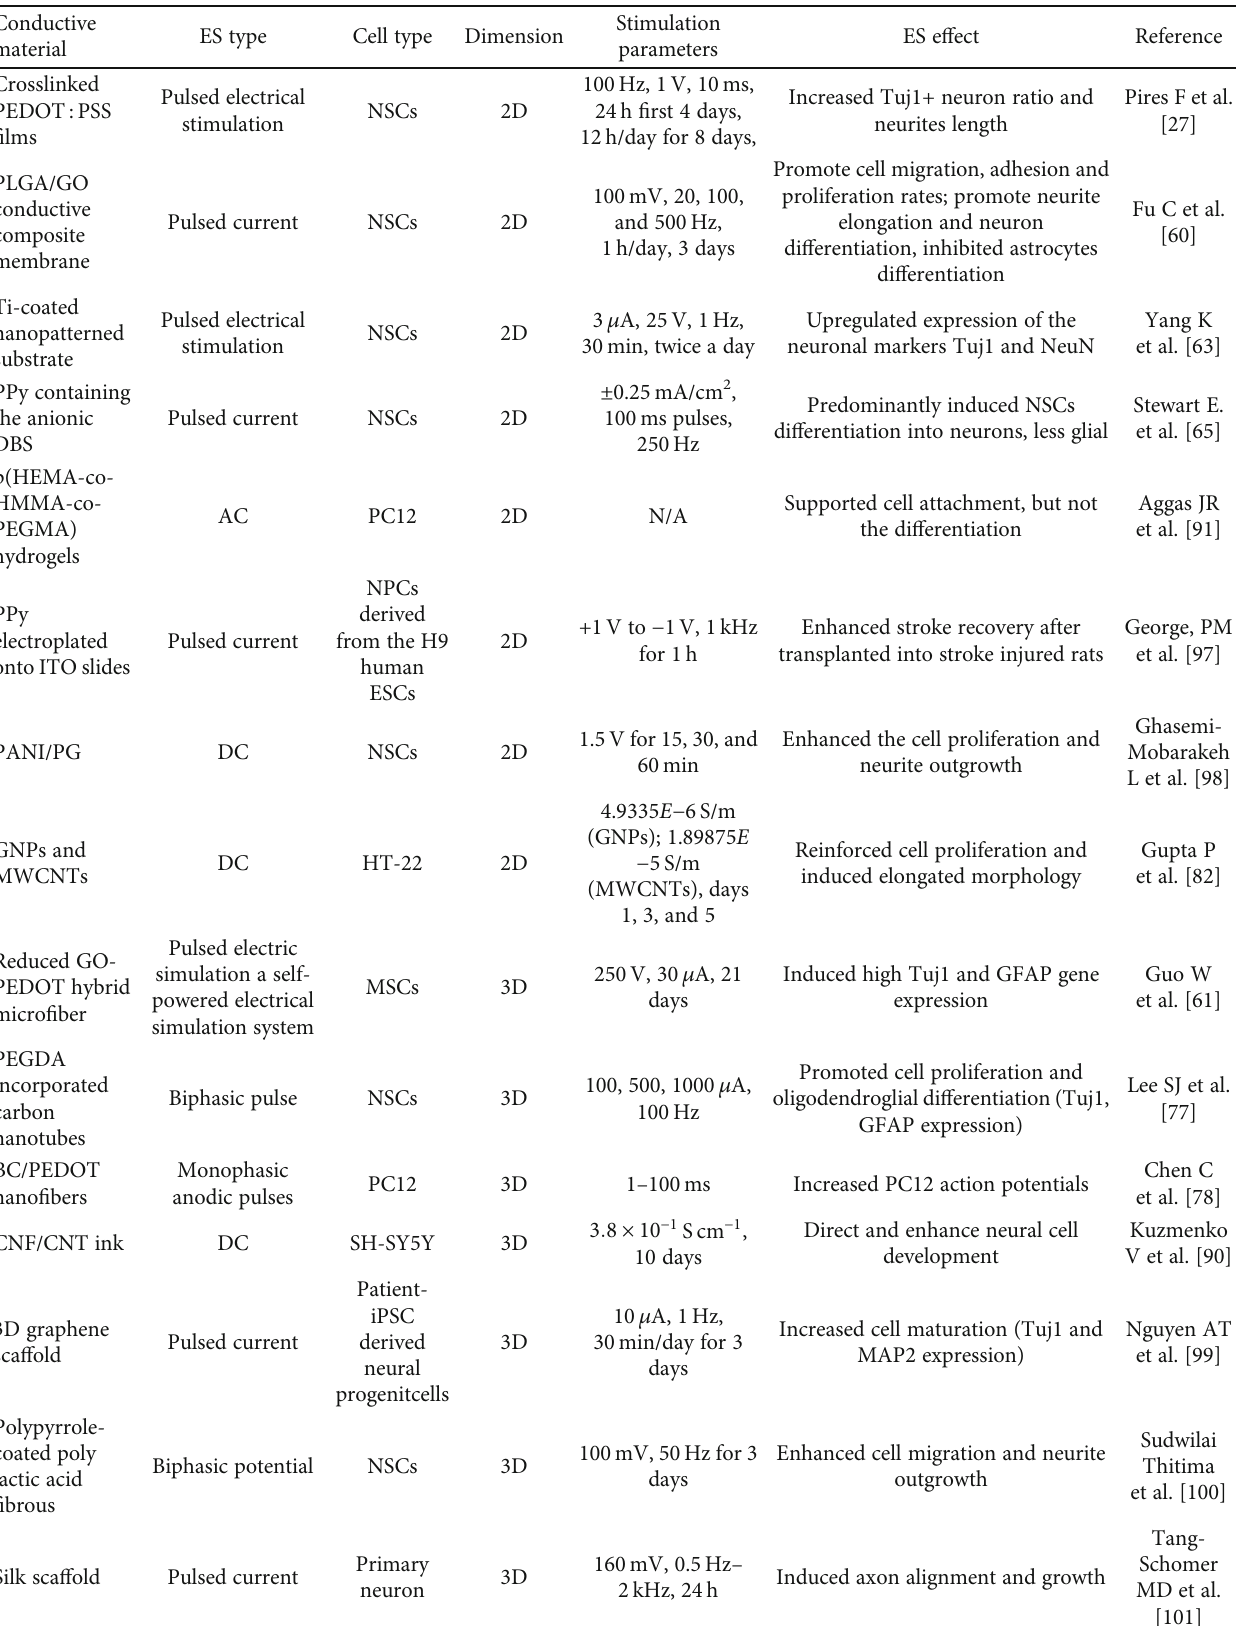
Table 5: Electrical stimulation through conductive materials for stem cell neural di ff